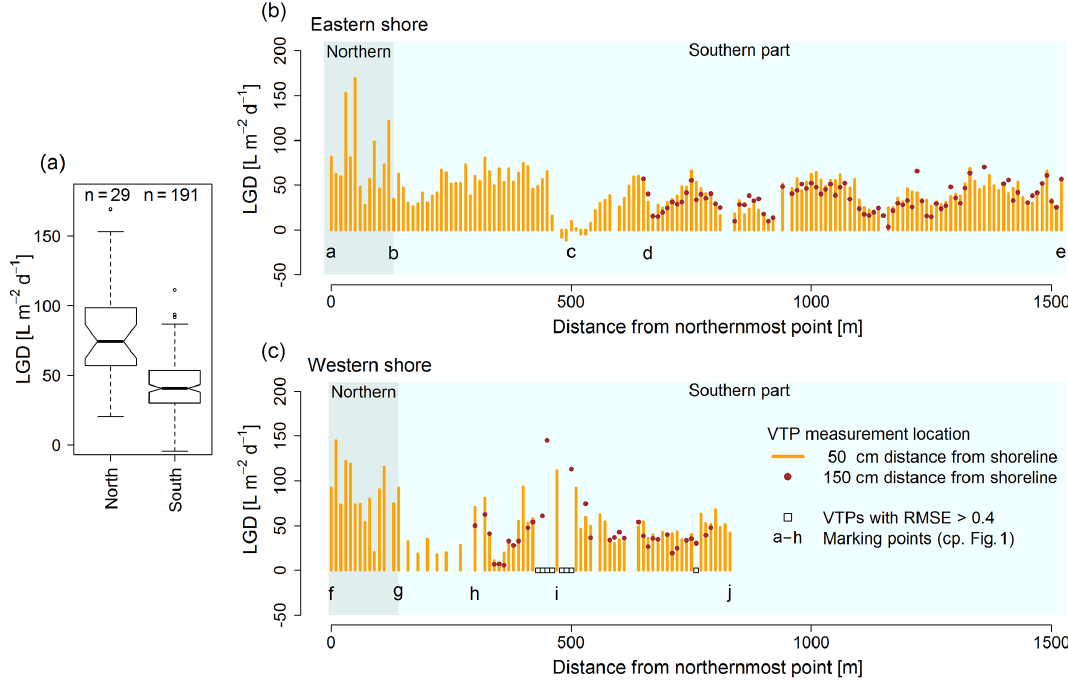
Figure 2. LGD estimated from VTPs measured at 50 and 150cm distance from the shoreline: LGD distribution from VTPs in the northern and southern parts measured at a distance of 50cm (a) , LGD along the eastern shore (b) and LGD along the western shore (c) . Locations where fits of the heat transport equation were poor (RMSE > 0 . 4) are indicted with squares.